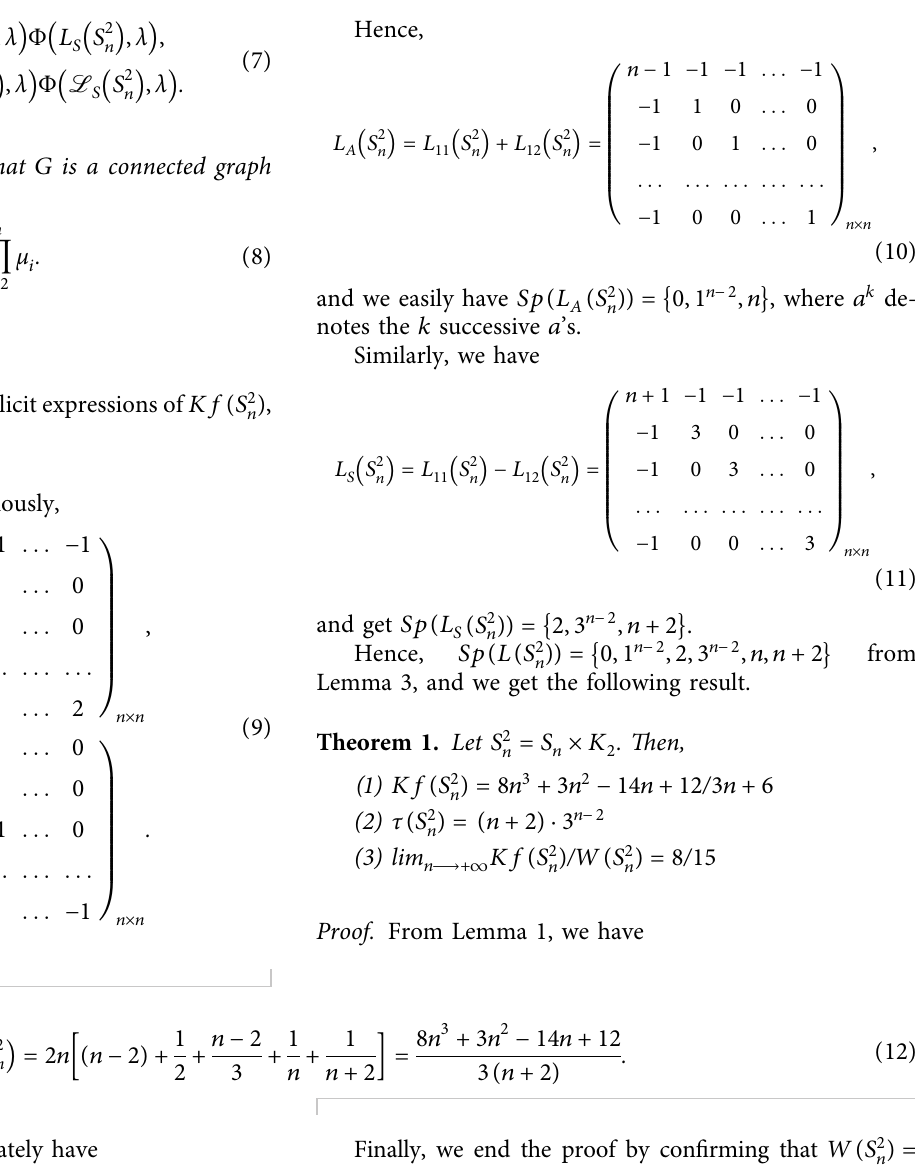
K and S n × K n ⊗ 2